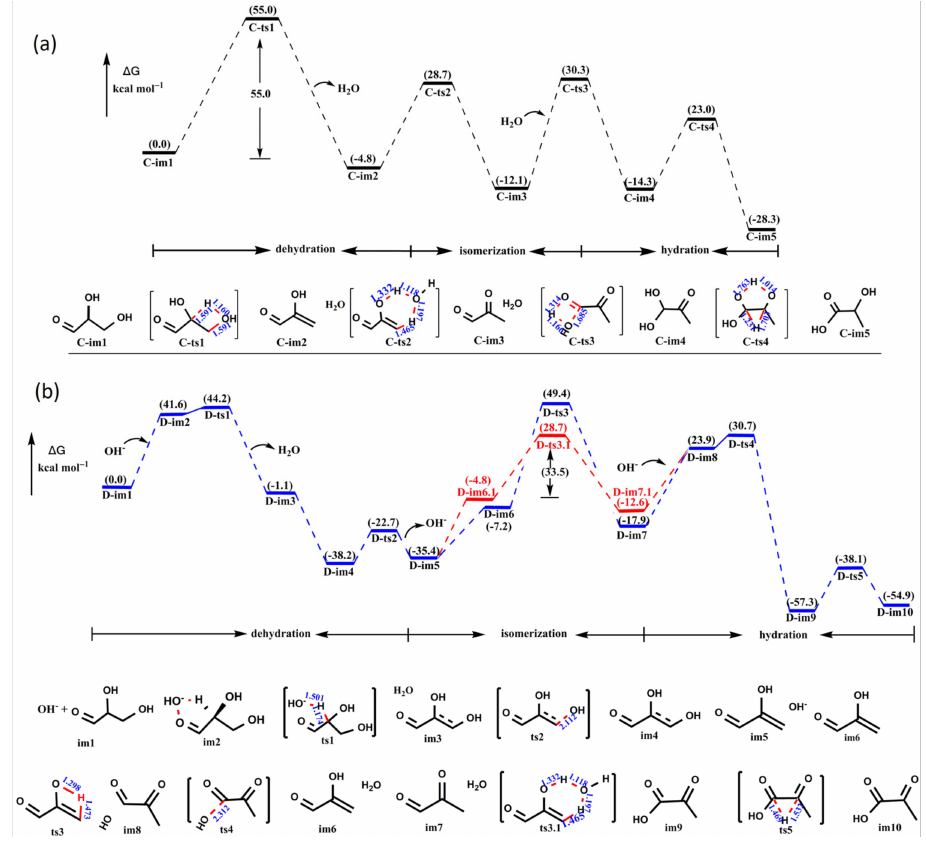
Figure 3. Energy profile for the dehydration and hydration background reaction of 2,3- dihydroxypropanal to lactic acid (path ( a ): with the addition of the hydroxyl; path ( b ): without the hydroxyl).